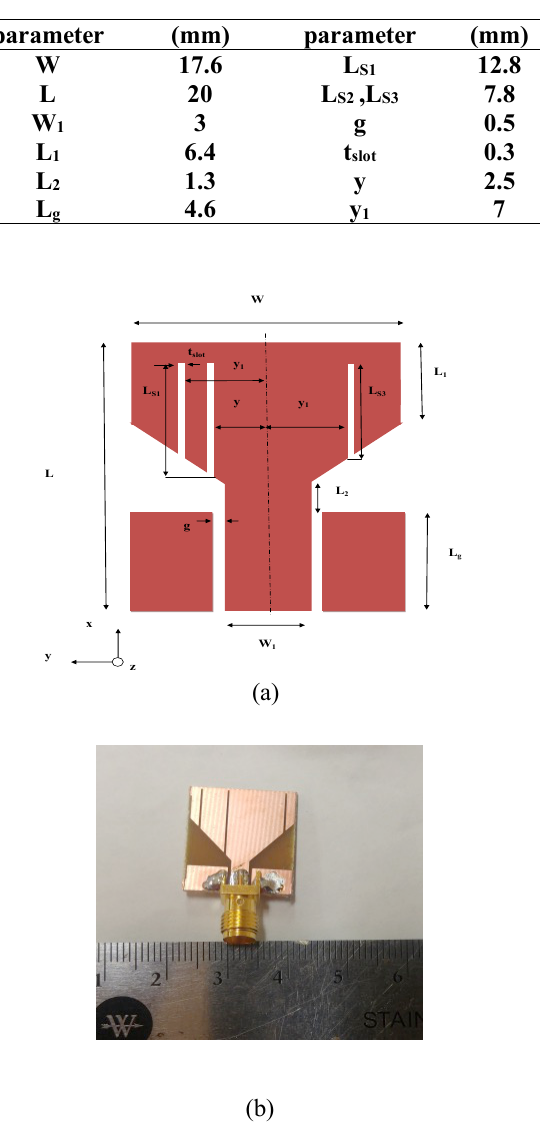
Figure 1: (a) Geometry of the antenna. (b) Photograph of the fabricated antenna.